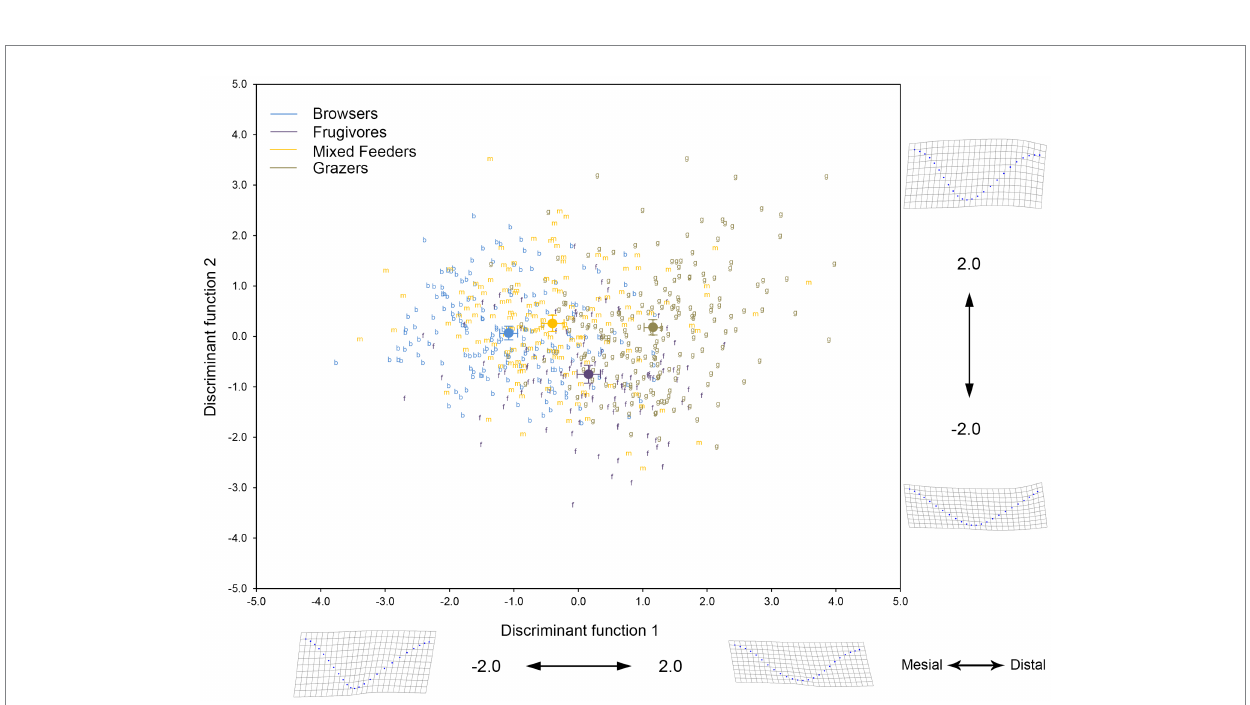
FIGURE 5 Scatter plot of the first two discriminant function scores derived from DFA of Procrustes transformed coordinates shown in Supplementary Table S1. Indicated in the plot are the centroids for each dietary group with corresponding 95% confidence intervals. The shape models located along the margins of the plot demonstrate the change in cusp shape along each axis. Abbreviations are as follows: b = browser, f = frugivore, g = grazer, and m = mixed feeder. Only Procrustes transformed coordinates for specimens of species with high-quality dietary information (Table 1) were used in this analysis ( n =